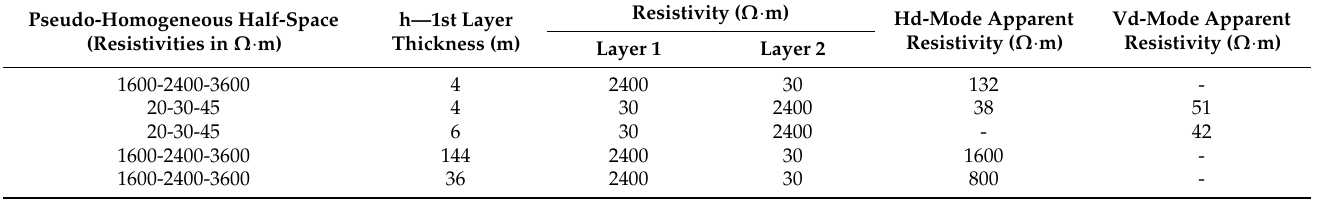
Table 2. EM-31 Hd-Mode and Vd-Mode model results (obtained with the equations in [18]); see Figure 7.